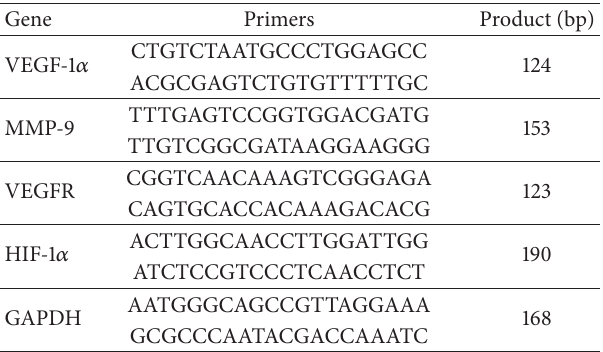
Table 1: The primers’ sequences for real-time quantitative